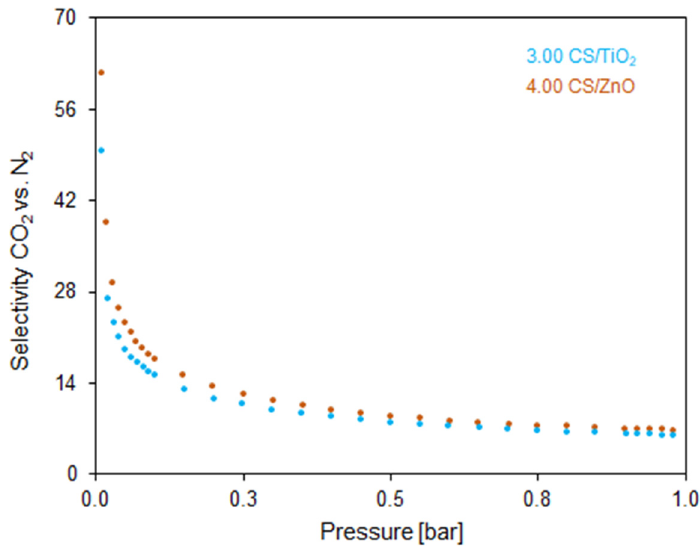
Figure 12. Selectivity of CO 2 over N 2 at 25 °C for 3.00 CS/TiO 2 and 4.00 CS/TiO 2 samples.